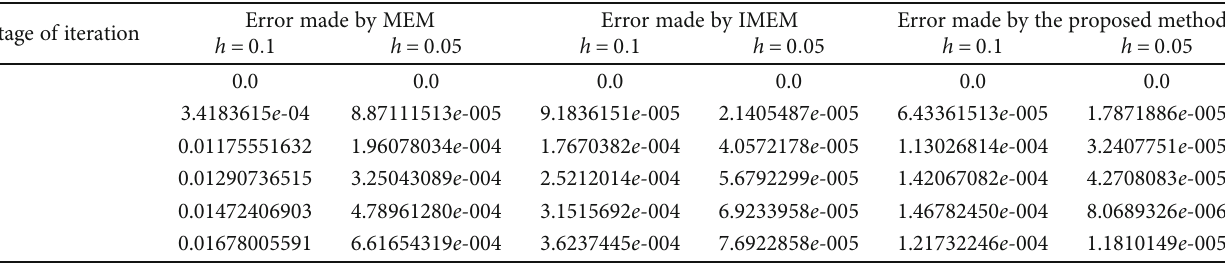
Table 4: Absolute errors made for Example 2.